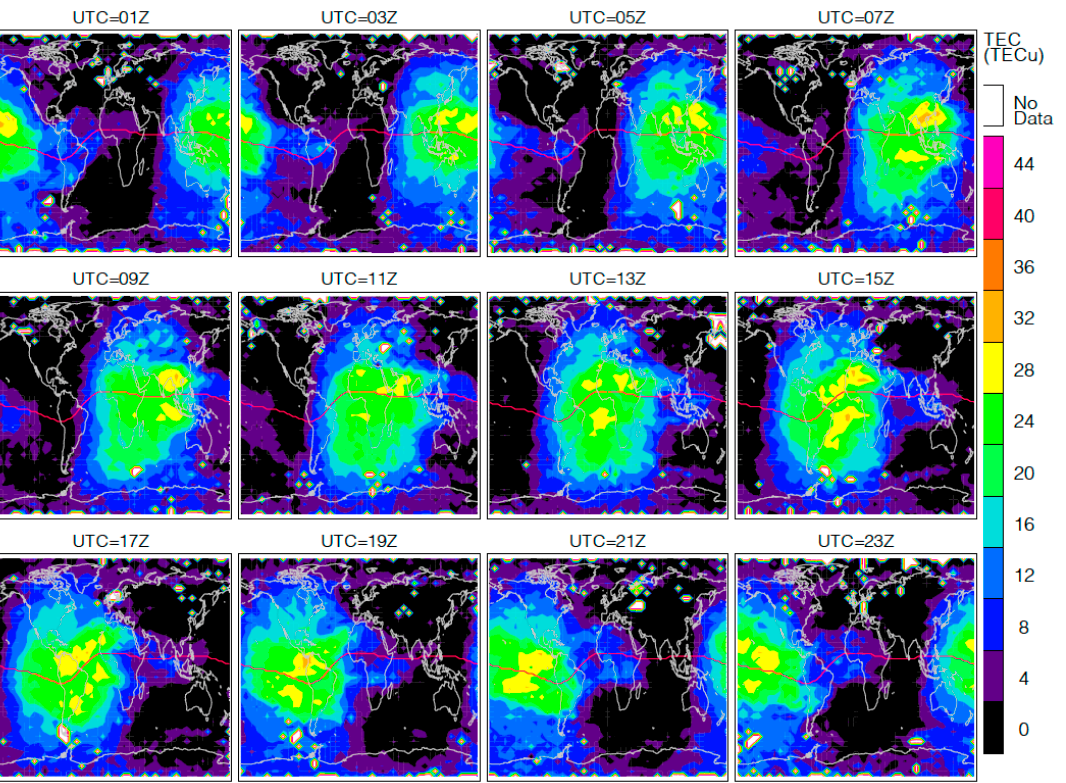
Figure 19. TEC maps from multiple GNSS-RO satellites/constellations (Spire, Metop-A, COSMIC-2, FY3-C/D, Kompsat-5, TSX, and PAZ) for October 2021. Satellite data with the high-rate RO acquisition top < 100 km are excluded in this TEC climatology. The monthly data are aggregated into a 4° × 8° latitude–longitude and 2-hourly local time bins. The grid boxes without any measurements are colored in white.